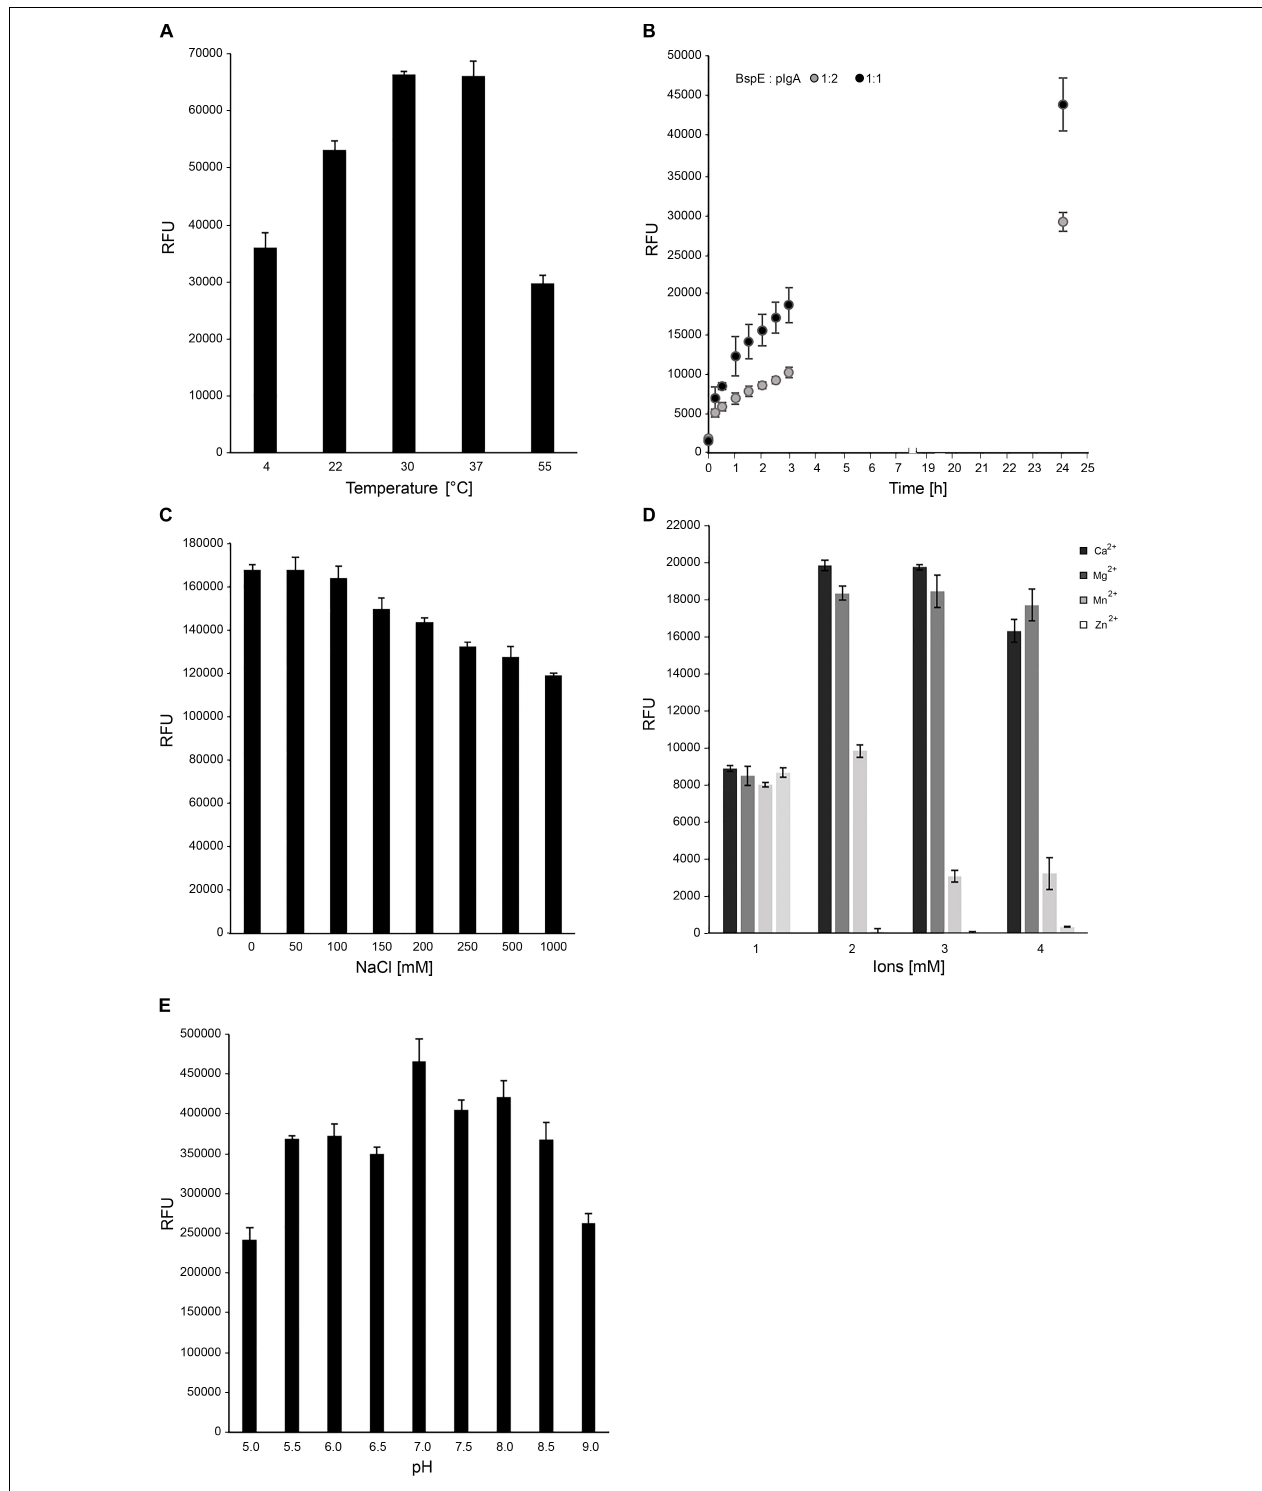
FIGURE 4 | Optimal biochemical conditions for BspE activity. (A) BspE activity at increasing temperatures (4–55 ◦ C). (B) BspE activity over time at 37 ◦ C (0–24 h). (C) BspE activity with increasing concentrations of NaCl (0–1000 mM). (D) The effect of Ca 2 + , Mg 2 + , Mn 2 + , and Zn 2 + at increasing concentrations (0, 2, 5, 10 mM) on BspE activity. (E) BspE activity at increasing pH, ranging from 5.0 to 9.0. Assays (A–C) were analyzed using the fluorescence-based assay EnzCheck Protease Assay. Assays (D,E) were analyzed by SDS-PAGE and densitometrically quantified. Enzymatic activity was measured as relative fluorescence units (RFU). Data is plotted as mean values ±